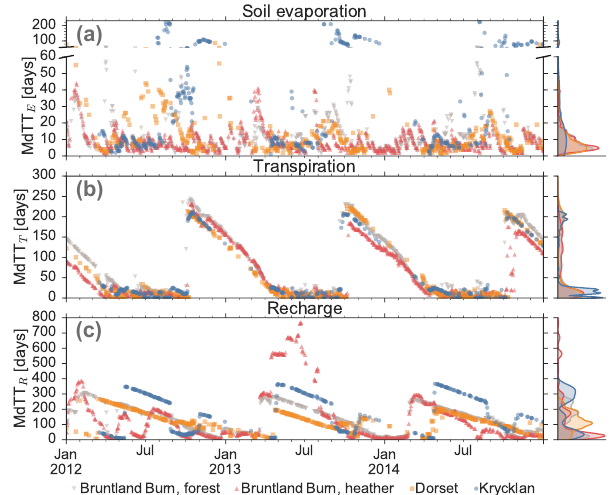
Figure 2. Median travel times (MdTT) of water infiltrating into the soil on a specific day (given on the x -axis) until leaving the soil (a) via soil evaporation (MdTT E ) , (b) transpiration (MdTT T ) , or (c) recharge (MdTT R ) flux. Colour code according to the four studied sites. Note that for days without precipitation or snowmelt, no travel times could be calculated. In subplot (a) , the y -axis has different scales for MdTT E <60 days and >60 days. Density distri- butions of the travel times are shown for each site on the right-hand